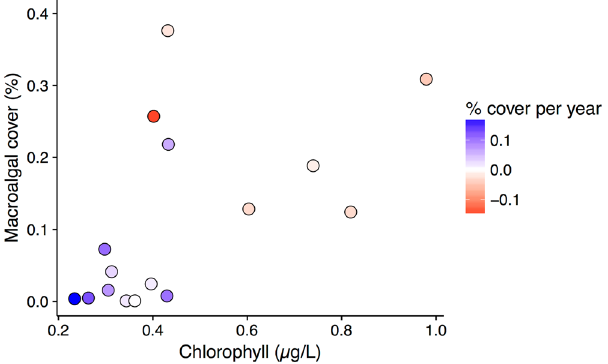
Figure 5. Change in Cliona orientalis cover was highest at locations with low chlorophyll concentration and low macroalgal cover. Points represent average macroalgal cover and chlorophyll a concentrations for each location and the color indicates the direction of change in C . orientalis cover.